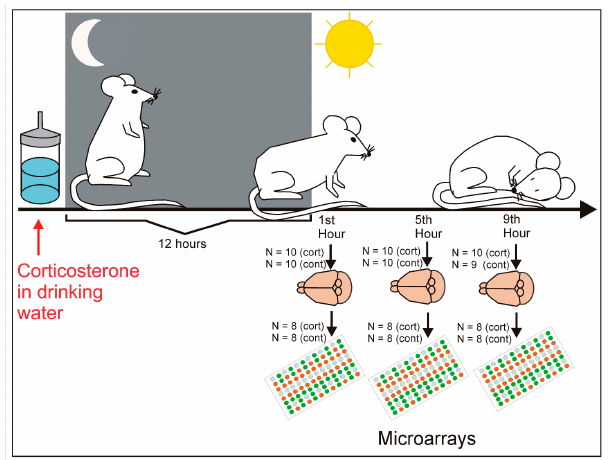
Figure 6. The design of the experiment. Mice received either corticosterone solution or vehicle at the end of the light phase, followed by 12 h of dark phase which is a period of mouse activity. The next day, the animals were sacrificed at three time points to collect brain samples for transcriptomic analysis performed with microarrays. For more details please see Section 4.2.